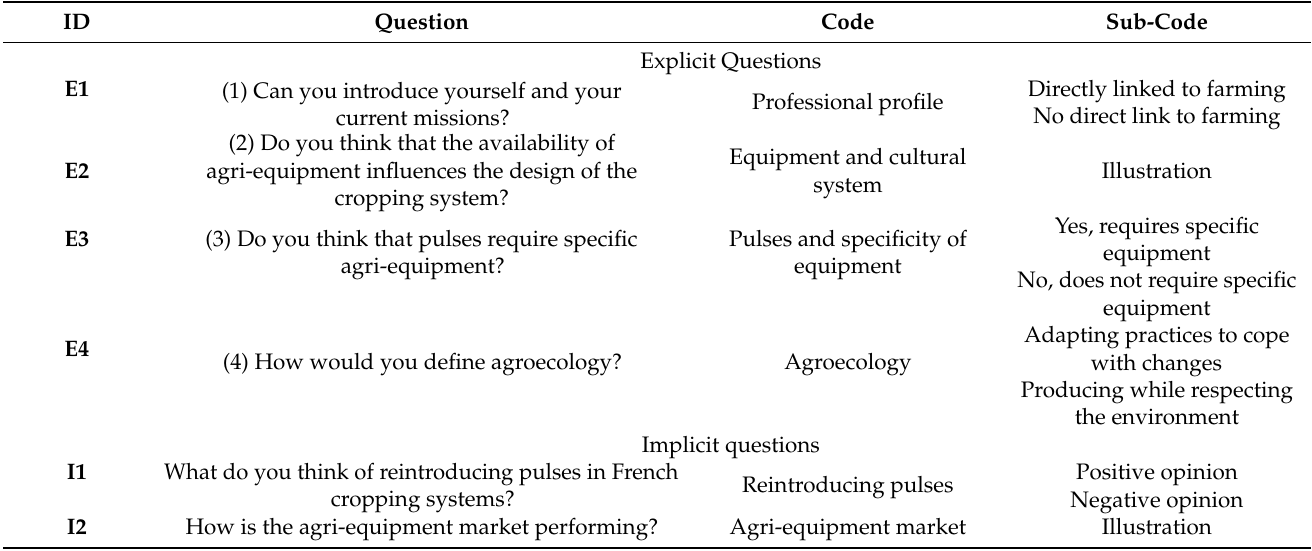
Table 1. Codes and sub-codes that were defined deductively to represent raw answers in the qualitative